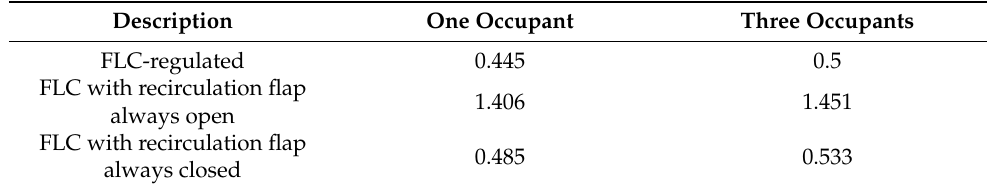
Table 6. Root mean square error for the PMV index with different simulation setups.